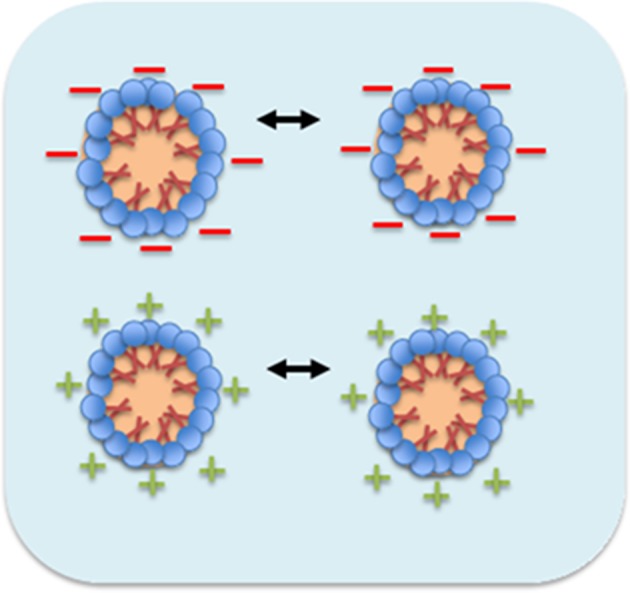
Mechanism of micellar nanoparticles stability in nanoemulsion system (Rai et al., 2018).